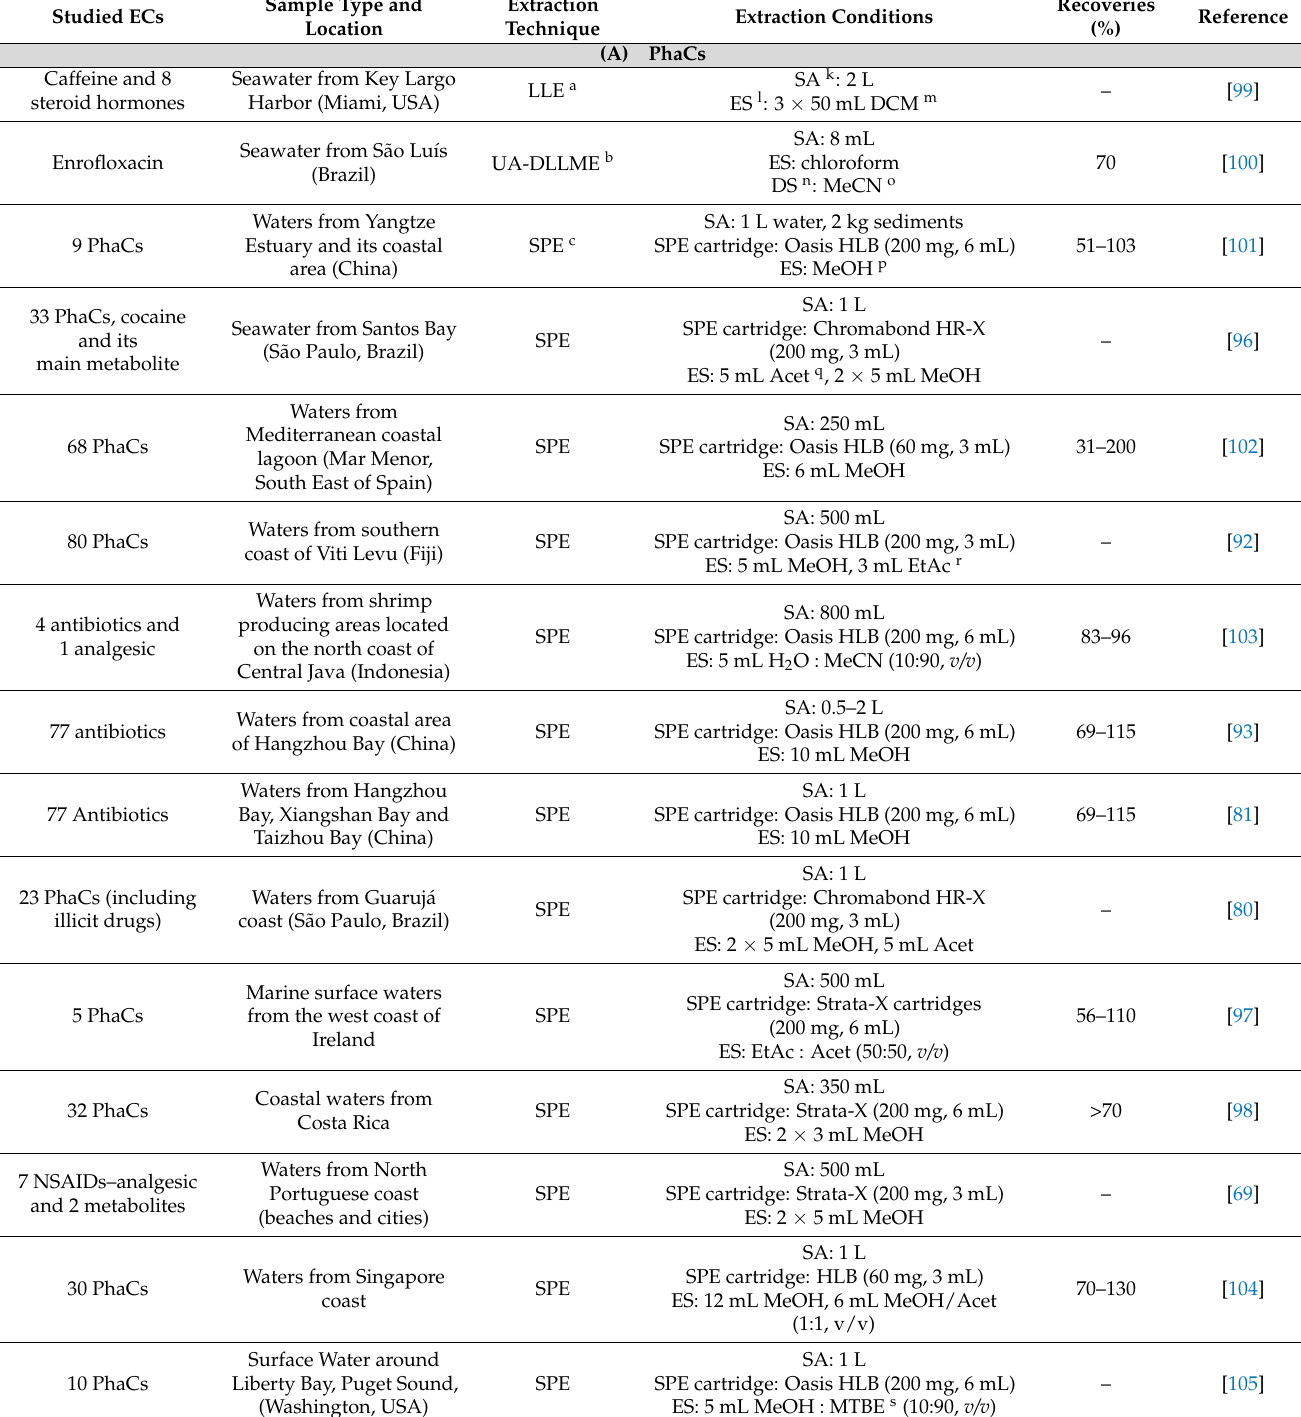
Table 4. Extraction methodologies for (A) pharmaceuticals (PhaCs) and (B) personal care products (PCPs) present in coastal liquid